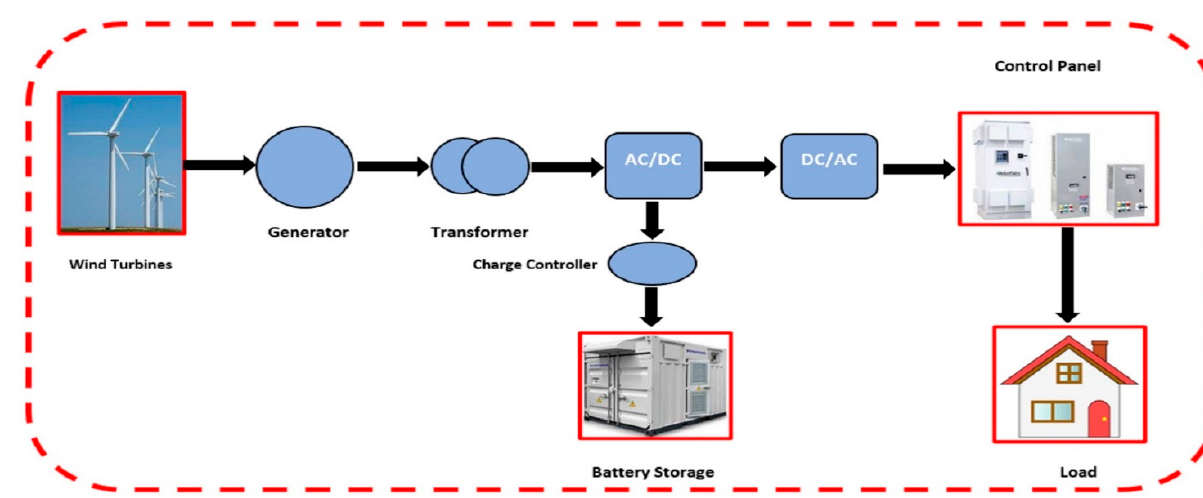
Figure 18 . Wind energy integration into the power system. Figure 18. Wind energy integration into the power